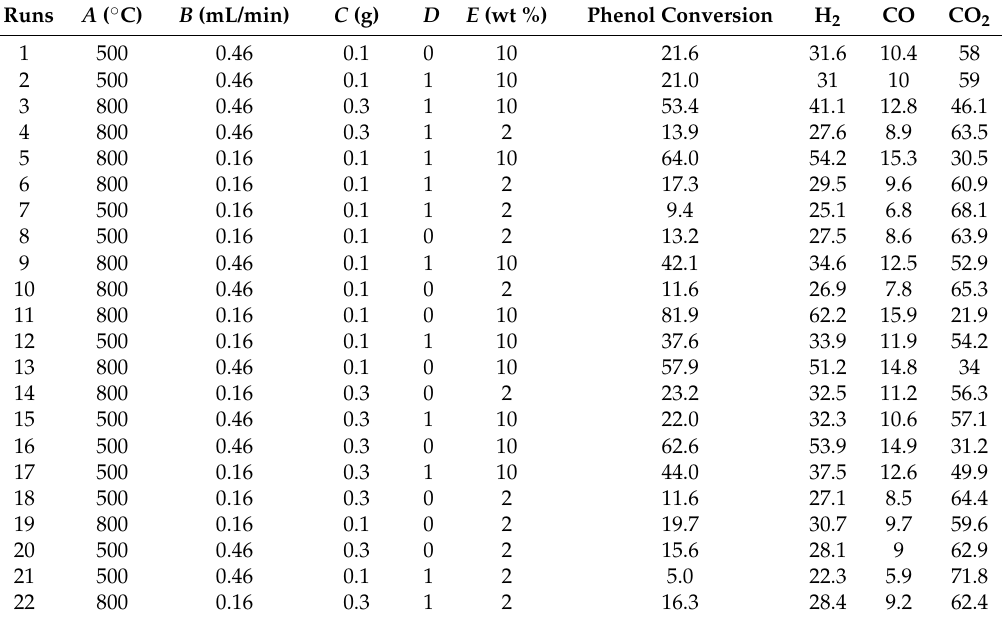
Table 2. Experiment matrix for the 2 5 factorial designs and experimental